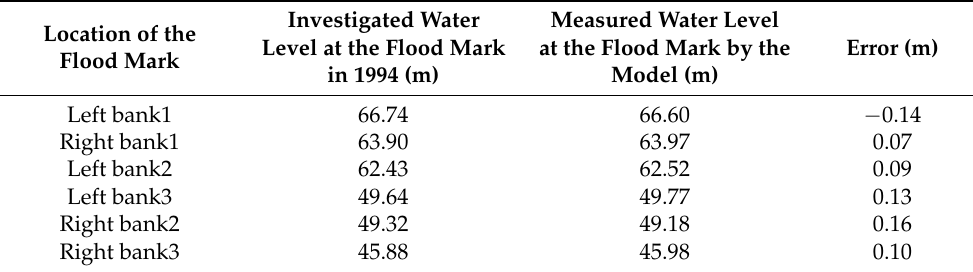
Table 2. Comparison validation of water levels investigated from the past flood mark and measured using the